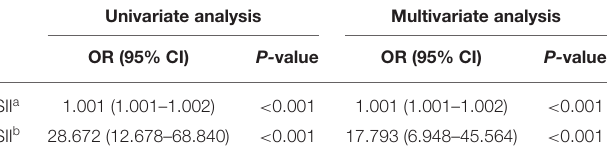
TABLE 5 | Associations of the SII with delayed cerebral ischemia. Univariate